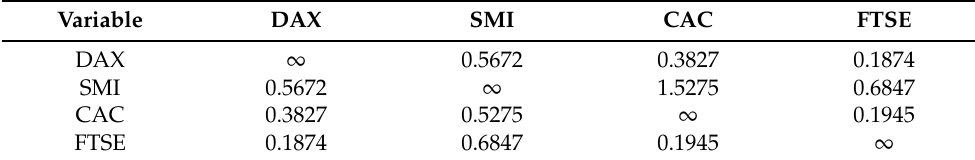
Table 3. Fitted copula parameter δ for the bivariate KW (Type II) copula.